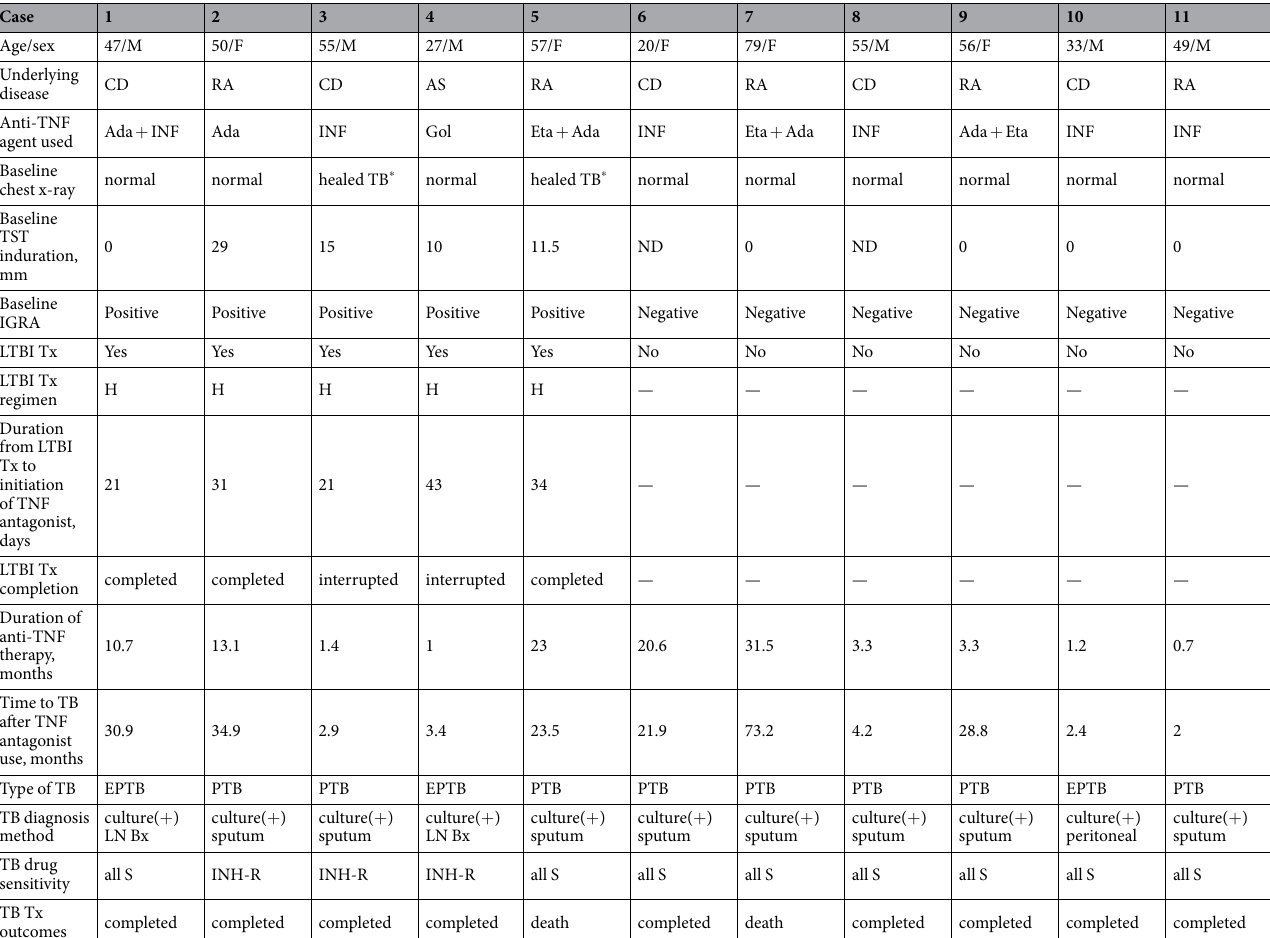
Table 3. Clinical characteristics of 11 active TB patients during or after TNF antagonists therapy. * Healed TB in chest radiography was defined as apical fibronodular lesions, calcified lymph nodes, calcified solitary nodules, and pleural thickening. TB, tuberculosis; TNF, tumor necrosis factor; CD, crohn’s disease; RA, rheumatoid arthritis; AS, ankylosing spondylitis; Ada, adalimumab; INF, infliximab; Gol, golimumab; Eta, etanercept; TST, tuberculin skin test; ND, not done; IGRA, interferon gamma release assay; LTBI Tx, latent tuberculosis infection treatment; H, isoniazid; EPTB, extrapulmonary TB; PTB, pulmonary TB; LN Bx, lymph node biopsy; all S, all sensitive; INH-R, isoniazid